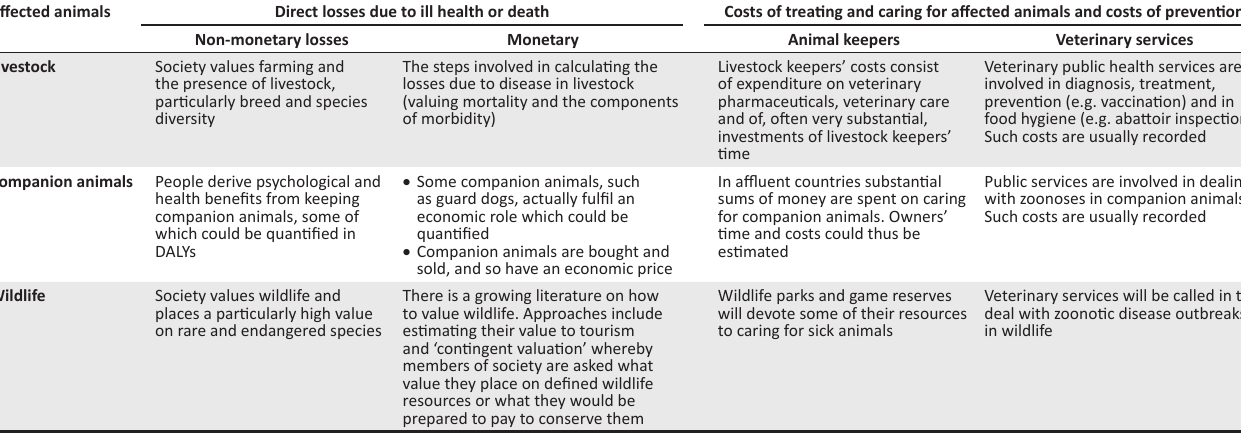
TABLE 2: Items for calculation of burden of disease in terms of Disability-Adjusted Life Years. Affected